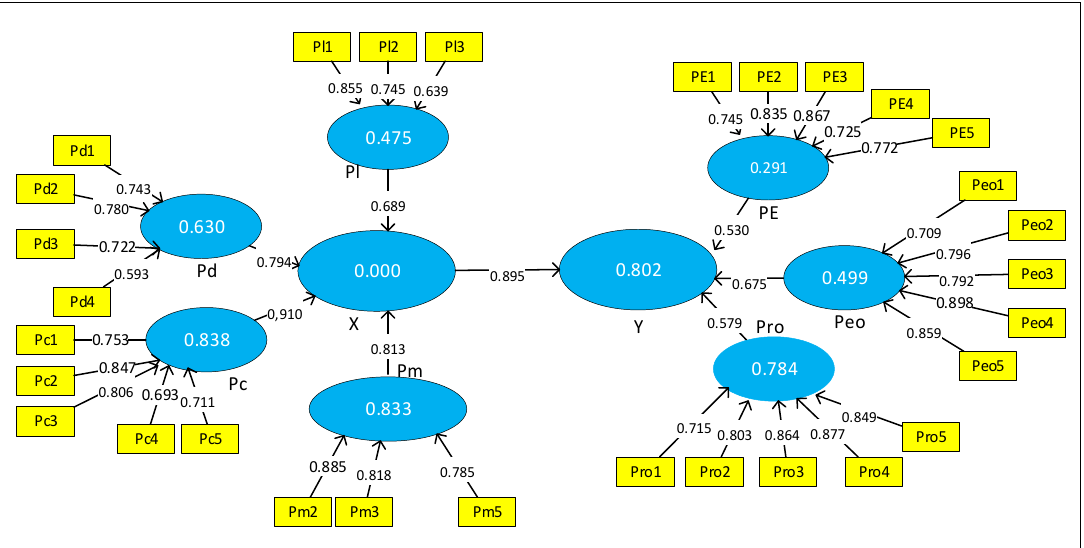
values 2 Factor loadings of the indicators, beta, and R 3.